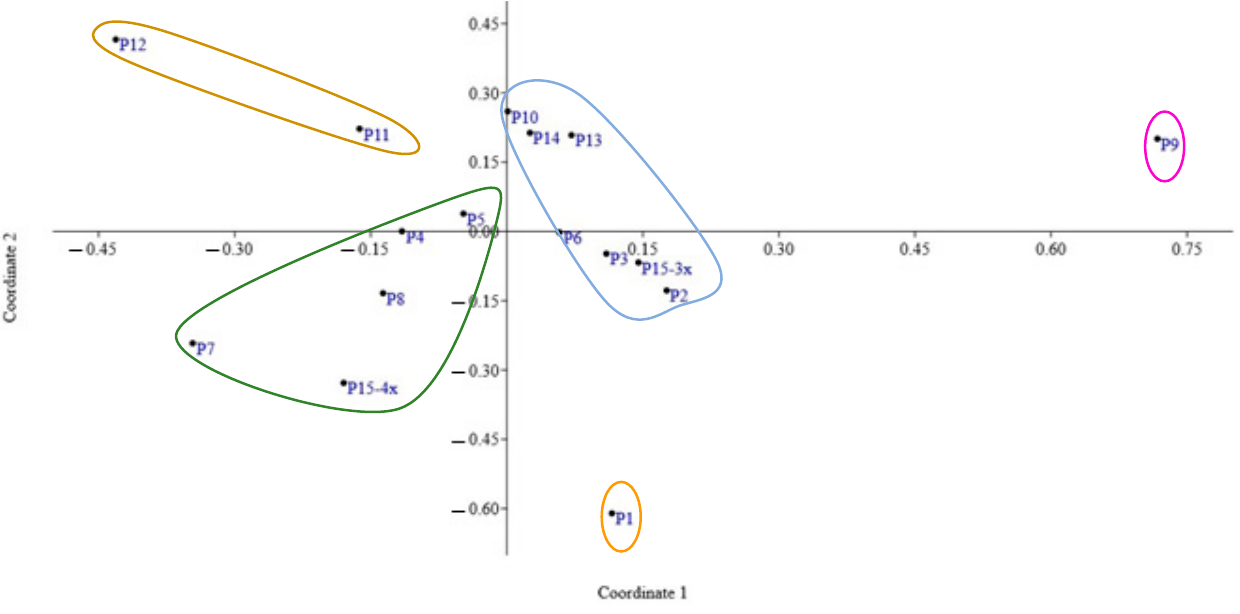
Figure 4. The scatter diagram of 15 Hypericum perforatum populations based on the first two coordi- nate of principal coordinate (PCoA) of the karyological parameters. of principal coordinate (PCoA) of the karyological